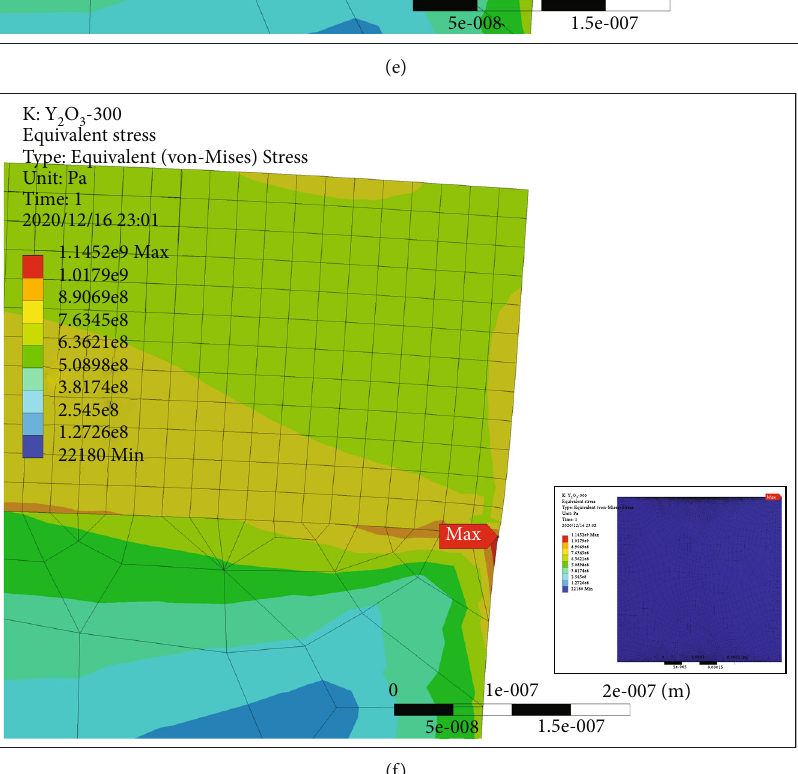
O , t = 300nm ); (b) max shear stress (Al 2 3 O , t = 300 nm ); (e) max shear stress (Y 2 3